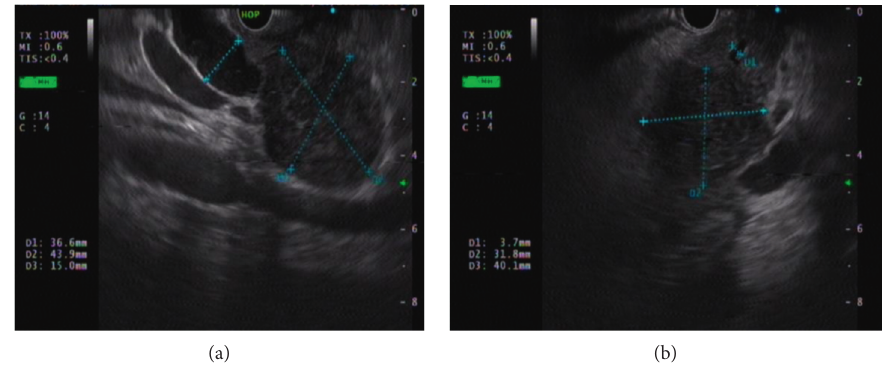
Figure 3: (a), (b) EUS showing a large inhomogenous hypoechoic mass (4 × 3.6cm in diameter) in pancreatic head region with dilatation of CBD (1.4cm) and both IHDs. Main pancreatic duct (MPD) is mildly dilated (3.4mm) in head region.